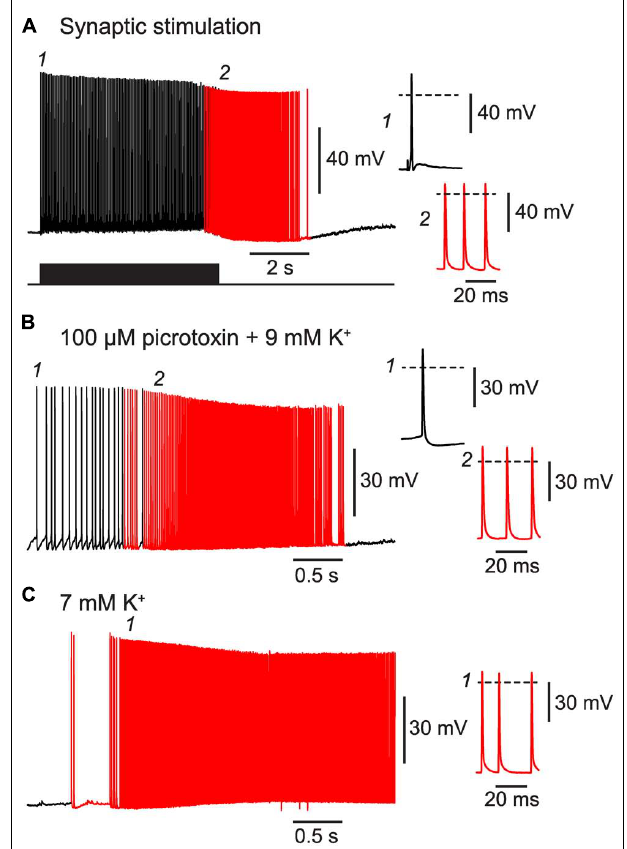
FIGURE 5 | BF can be triggered by trains of excitatory synaptic stimulation and by perfusing with proconvulsant bath solutions. All panels show recordings from a NG cell in layer 3 in acute slices of the piriform cortex. (A) , A train of extracellular synaptic stimuli at 20 Hz induces BF. Bottom trace shows the timing of the stimuli; red portion of trace indicates barrage-firing APs. (B) , Perfusion with a modified ACSF containing 100 μ M picrotoxin and 9 mM KCl triggers barrage-firing APs (red portions of trace), identified by their strongly hyperpolarized voltage thresholds. (C) , Perfusion with ACSF containing 7 mM KCl but no synaptic blockers also triggers barrage-firing APs. In this cell, low-threshold barrage-firing APs emerged without the prior activity of normal-threshold APs. In all panels, insets at right show (expanded) the AP responses at the time points indicated in the main panels at left (1, 2). Dashed lines indicate 0